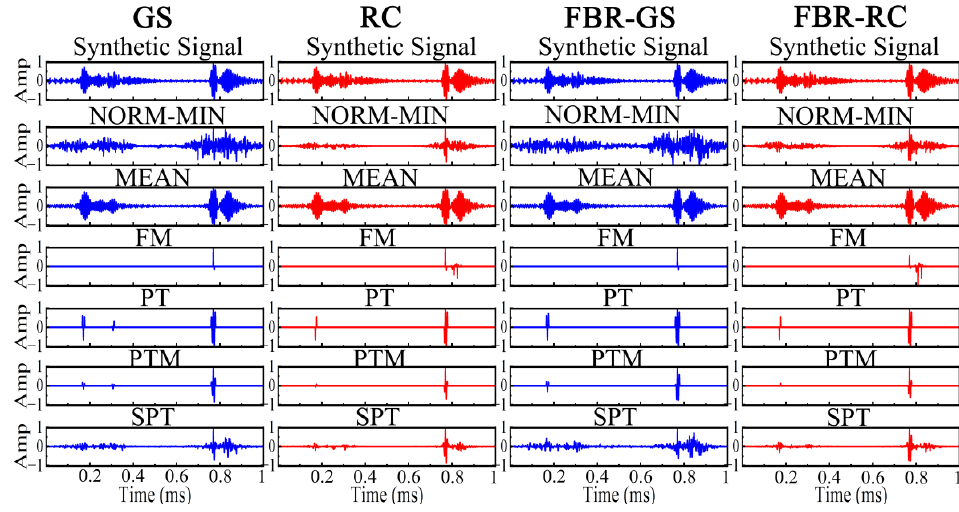
Figure 8. Synthesized UGW signals before and after applying SSPs based on GS, RC, FBR-GS and FBR-RC filters.